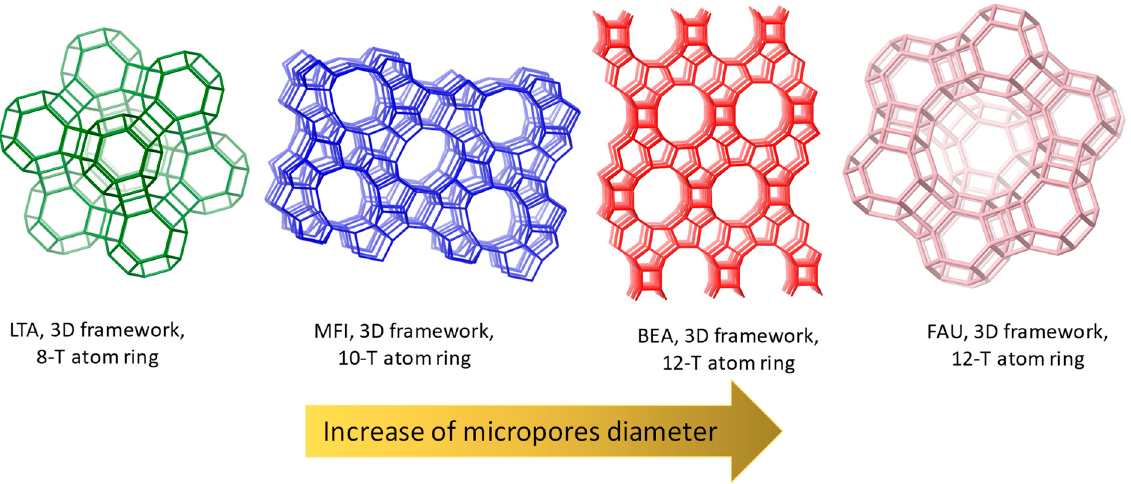
Figure 5. Microporous zeolites with different types of pores and channels, (images are produced by 3D drawing tool in database of zeolites structures, Accessed 17 March 2022) [78].